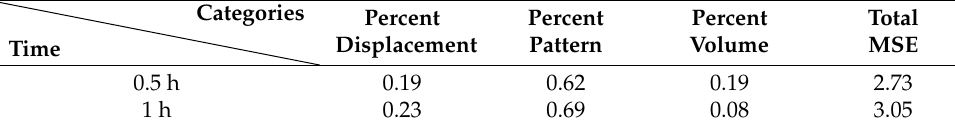
Table 6. TITAN algorithm extrapolation results’ CRA score.